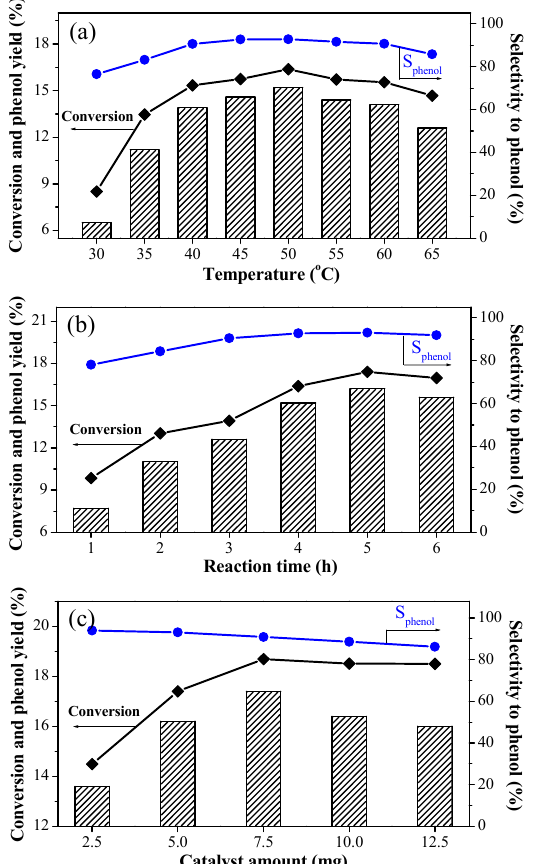
Figure 7. Effects of catalytic reaction temperature ( a ), reaction time ( b ), and catalyst amount ( c ) on catalytic activities over VG ‐ N ‐ A300 catalyst (benzene conversion ( ◆ ) yield (column) and selectivity ( ● ) of phenol). Reaction conditions: 0.3 mL of benzene, 5.0 mL of acetic acid, and 1.5 mL of 30% aq. H 2 O 2 ; ( a ) 5.0 mg of catalyst and t = 4 h; ( b ) 5.0 mg of catalyst and T = 50 °C; and ( c ) T = 50 °C and t = 5 h.